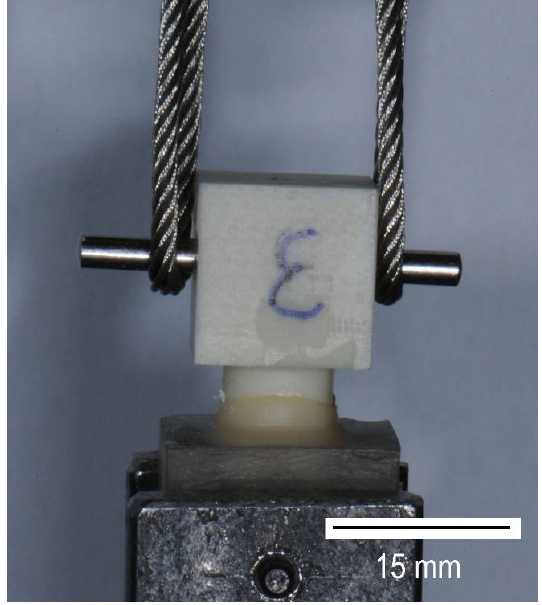
Figure 6. Pull-off device “Type 1445 universal testing machine” (Zwick GmbH & Co. KG, Ulm, Germany) including a mounted test specimen.